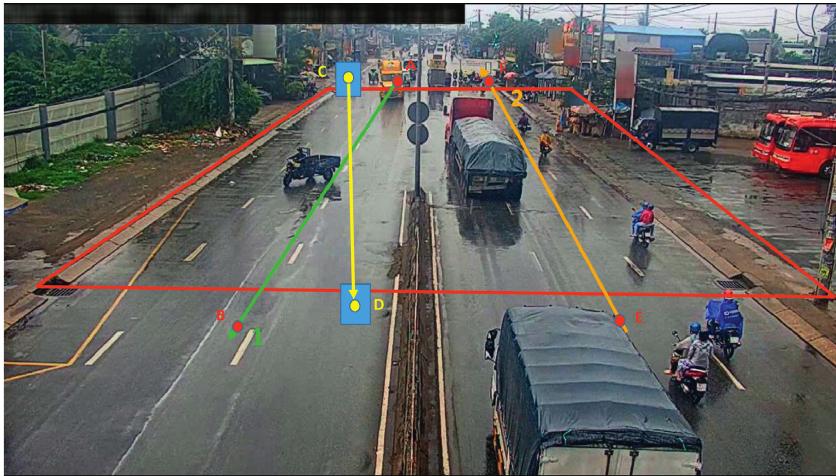
Figure 7: Illustration of calculating cosine similarity score in one-way and two-way road scenarios.